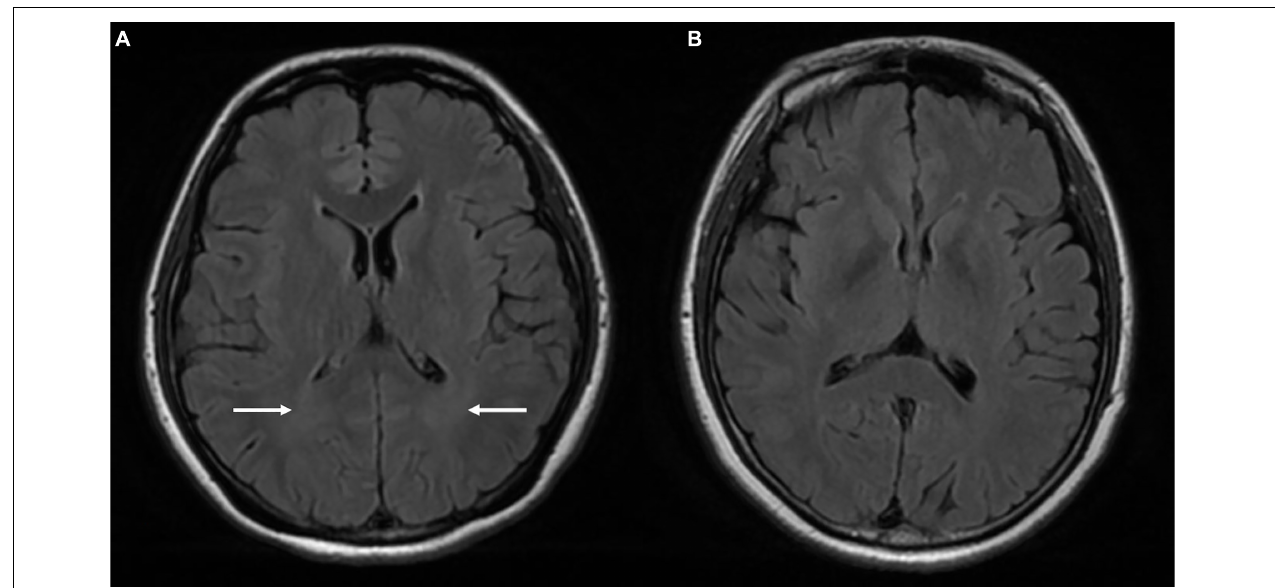
FIGURE 2 | Comparison of the MRI findings between a 33-year-old female patient with TSS (A) and a 42-year-old female healthy control (B) . Venous PT patient with TSS: T2 FLAIR (A) shows symmetrical cloud-like WM hyperintensity in the bilateral periventricular area (white arrow) that was absent in the healthy control (B) . PT, pulsatile tinnitus; TSS, transverse sinus stenosis; FLAIR, fluid attenuated inversion recovery; WM, white